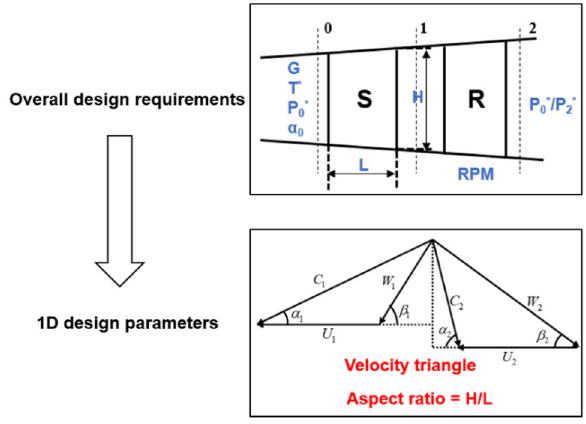
Fig. 1 Overview of the turbine 1D aerodynamic